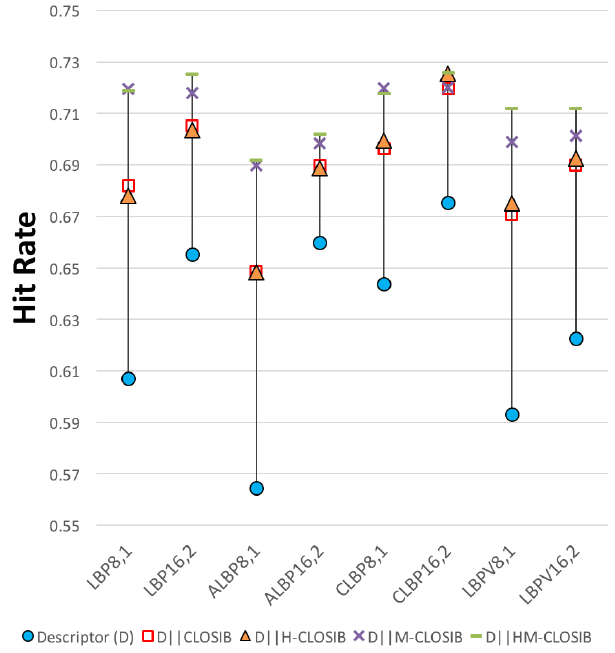
Figure 8. Hit rates obtained with a given LBP-based descriptor (LBP, ALBP, LBPV and CLBP) and the concatenations of the descriptor with CLOSIB variants.